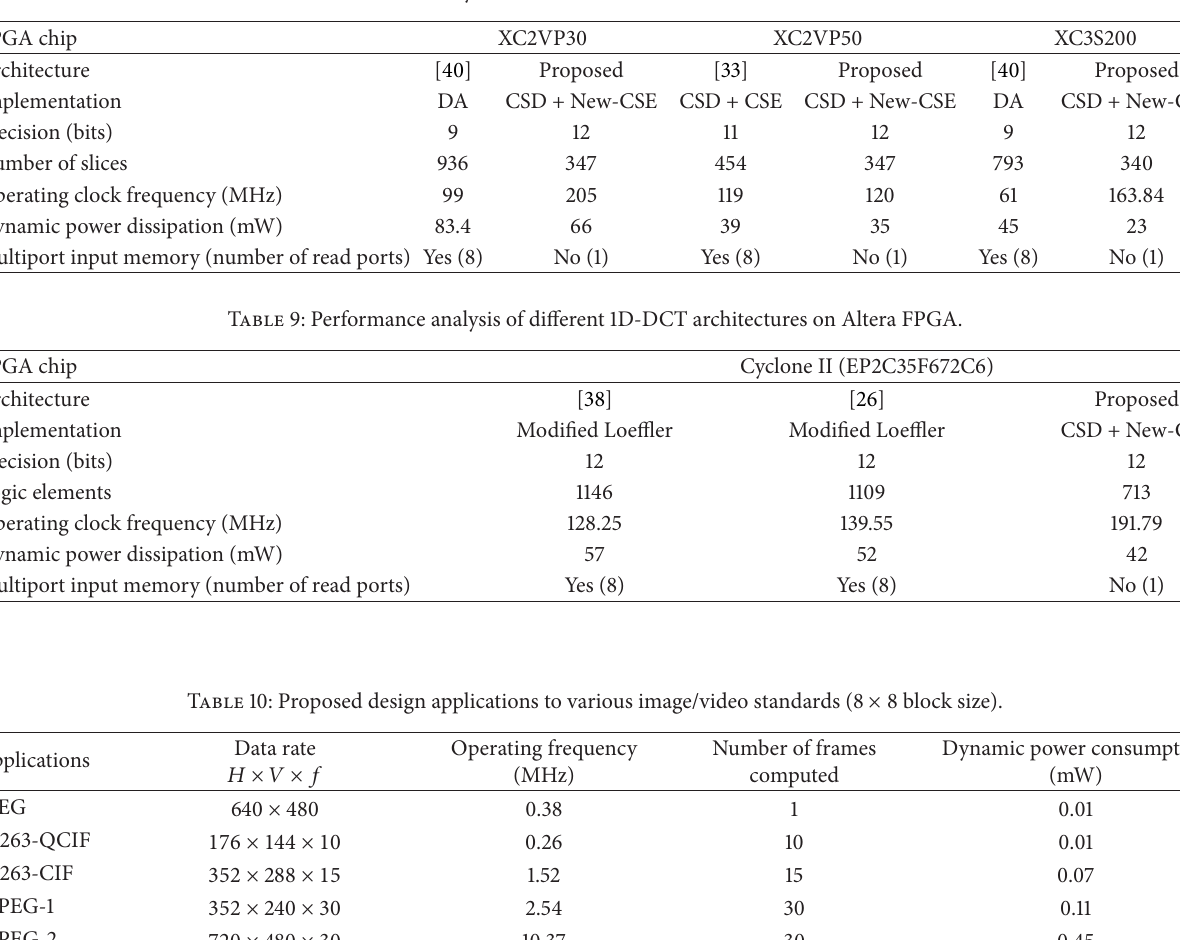
Table 8: Performance analysis of different 1D-DCT architectures on Xilinx FPGAs.